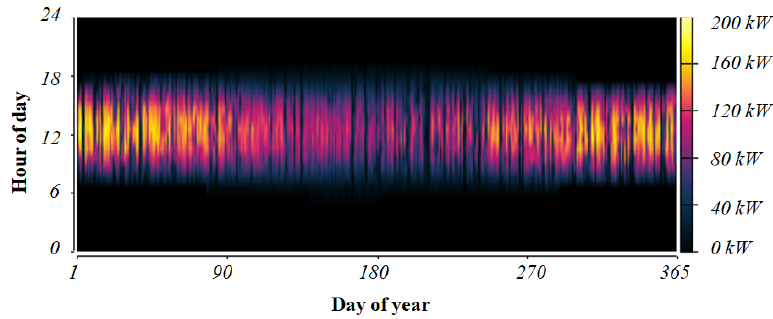
Figure A2. Power output from solar PV array in HEGS combination 3.